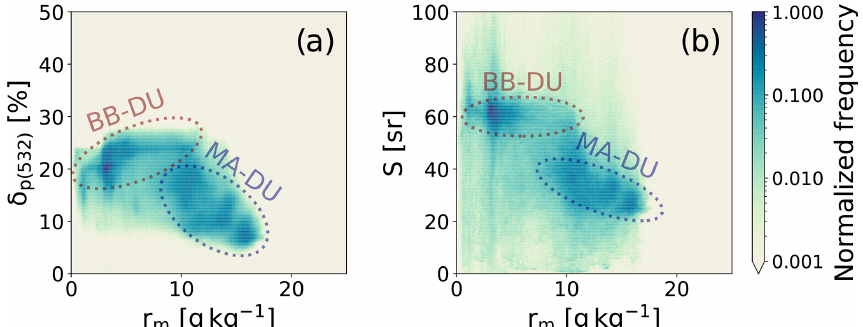
Figure 7. Two-dimensional histograms showing the joint frequency distribution of measured particle linear depolarization δ p (a) and lidar ratios S (b) with simultaneously measured water vapor mass mixing ratios r m during the three research flights over long-range-transported Saharan mineral dust. The dashed ellipses indicate an outline of the mixing regimes of aged biomass-burning aerosols with transported Sa- haran dust aerosols (BB–DU, maroon) as well as of marine aerosols with transported Saharan dust aerosols (MA–DU, blue). The histograms are normalized to their respective maximum bin